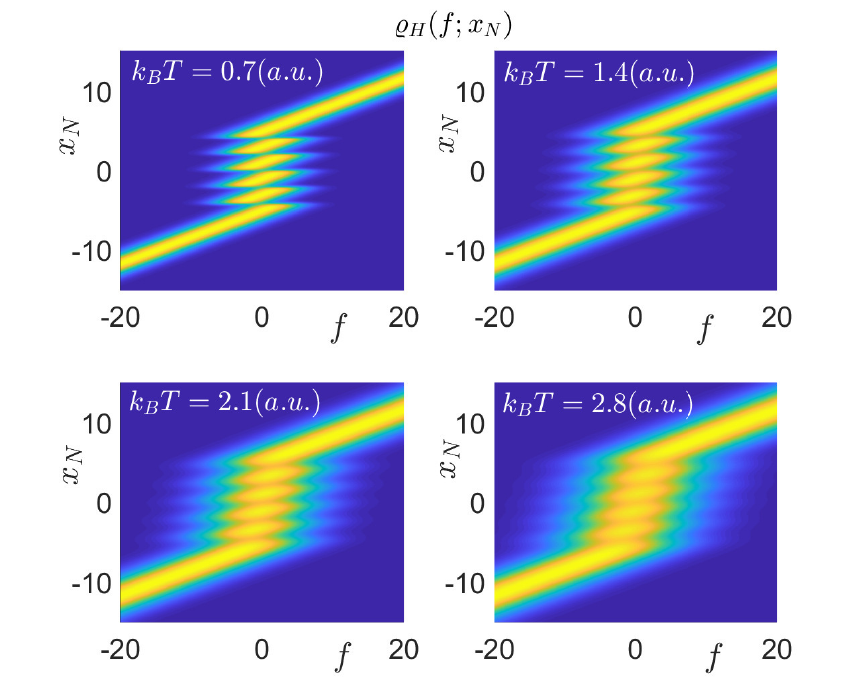
Figure 9. Two-dimensional representation of the Helmholtz density (cid:36) H ( f ; x N ) (see Equation (54)) obtained with N = 5, (cid:96) = 1 (a.u.), k = 15 (a.u.) and k B T = 0.7, 1.4, 2.1, 2.8